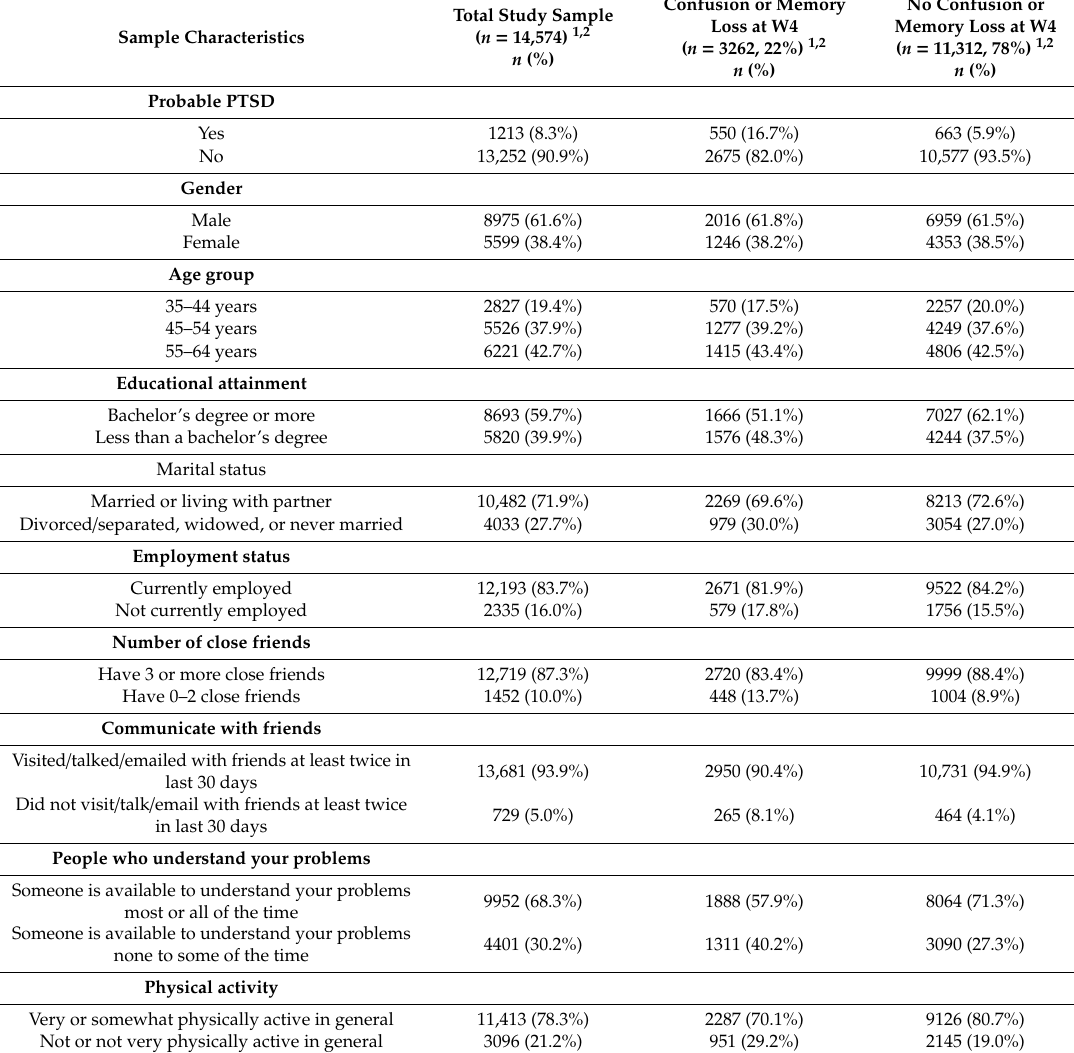
Table 1. Description of study sample demographics and cognitive reserve